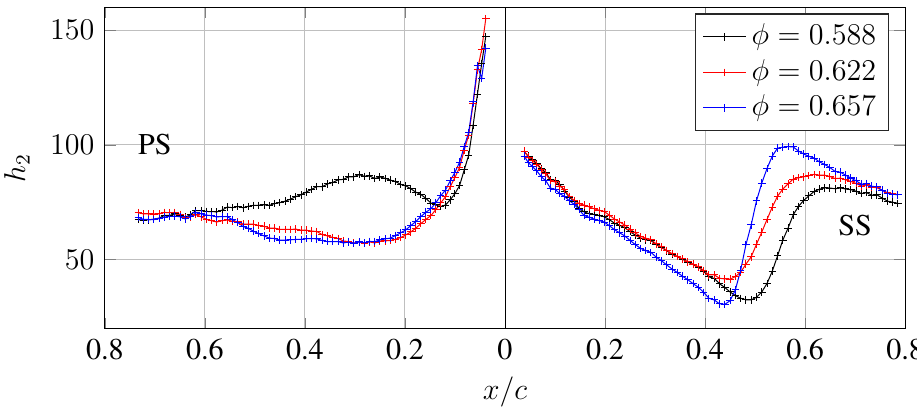
Figure 11. Chordwise distribution of air-side HTC at vane midspan for all cases